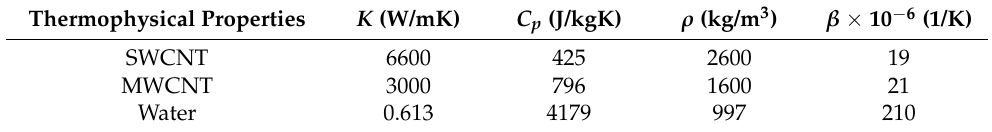
Table 1. Base fluid and nanoparticles numerical values for thermophysical properties [50].